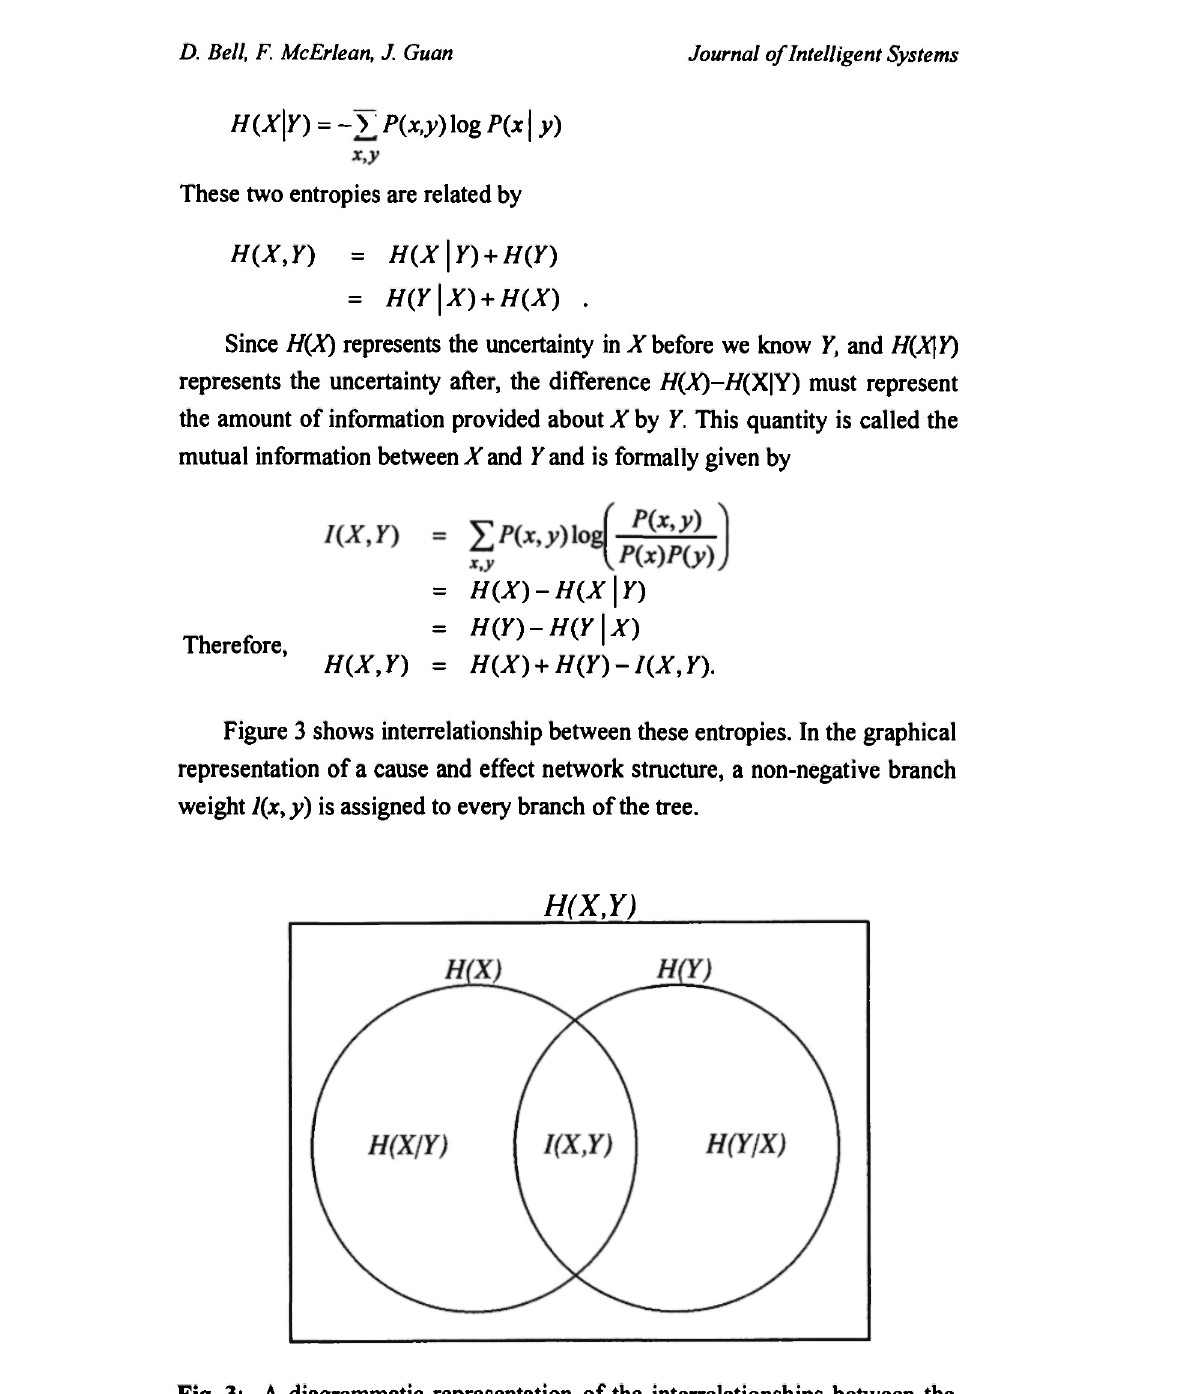
Fig. 3: A diagrammatic representation of the interrelationships between the entropies and mutual